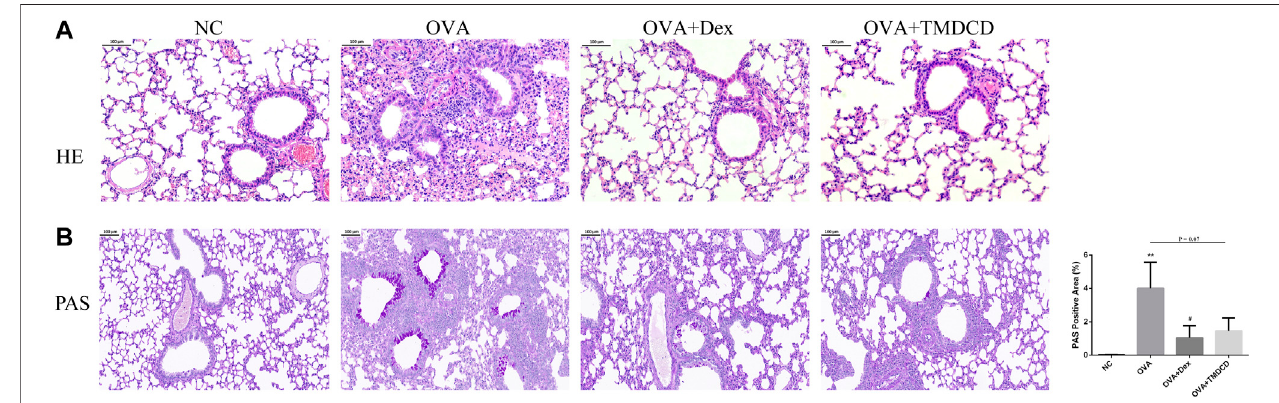
FIGURE4| H&EandPASstainingofmicelung tissue. (A) Histopathology:in fi ltration ofin fl ammatorycellsaroundthebronchus(H&E staining,magni fi cation × 100). (B) Histopathology: secretion of mucus around bronchus (PAS staining, magni fi cation × 100). The results were expressed as Mean ± SEM. Compared with NC group,